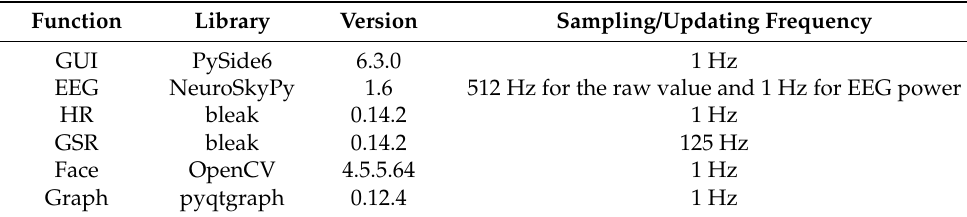
Figure 3. The biometrical sensor, devices, and development board used in this study. The total cost of these devices was about USD 800, which is a significant cost saving when compared with a medical-grade system. Table 3. Libraries used for the biofeedback system developed in this study.